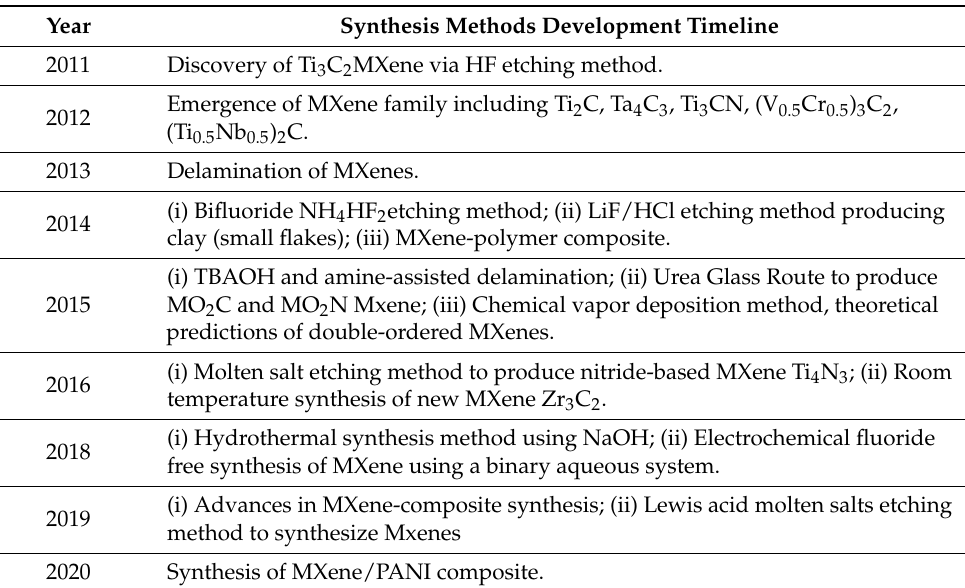
Table 1. Timeline of evolution of MXene and important breakthroughs in this field.